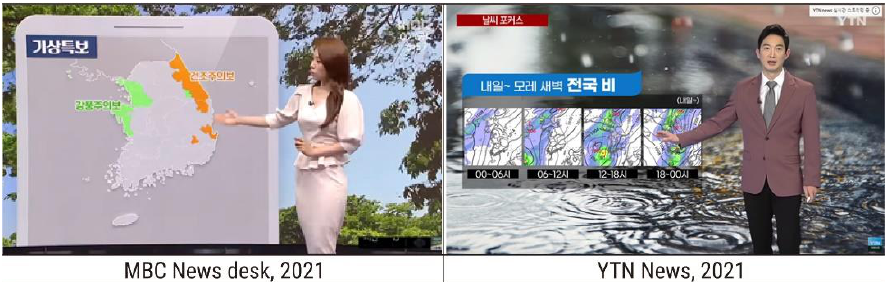
Figure 7. Examples of general weather broadcasts without sign language service. As in the example on the left in Figure 8, a Korean sign language interpreter is placed in the lower right corner, similar to other types of broadcast, or an American sign language interpreter appears in person together with the caster, as in the photo on the right. When an actual sign language interpreter appears together, the weather caster remains on the right and the sign language interpreter is located on the left. Since most of the basic content is arranged for an audience with normal hearing, some of the weather information is usually blocked by the interpreter unless the screen arrangement is changed accordingly.